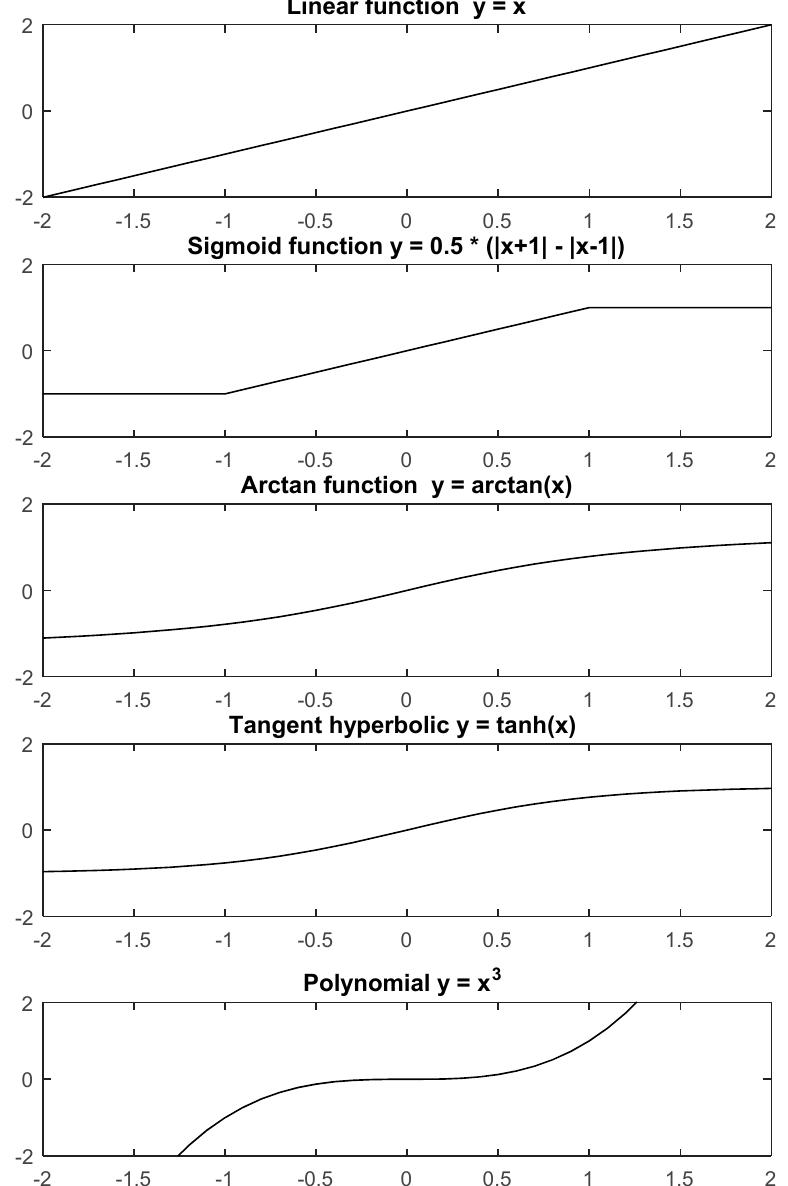
Figure 1. Illustrative examples of monotonic functions which can be used for solving the inversion of a time-varying matrix through Equation (29) .